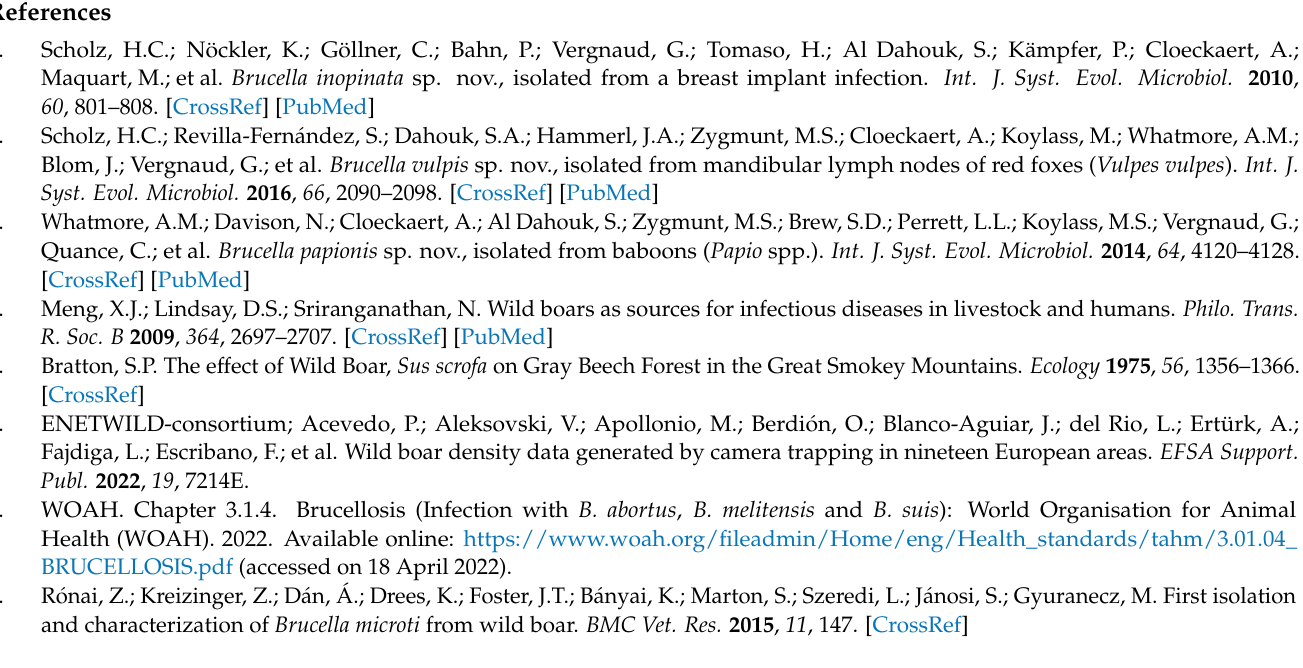
Summery statistics; Table S3: Goodness of fit statistics (Variable ELISA); Table S4: Standardized coefficients (Variable ELISA); Figure S1: Standardized coefficients (Variable ELISA); Figure S2: ROC Curve (Variable ELISA) AUC- Area under the